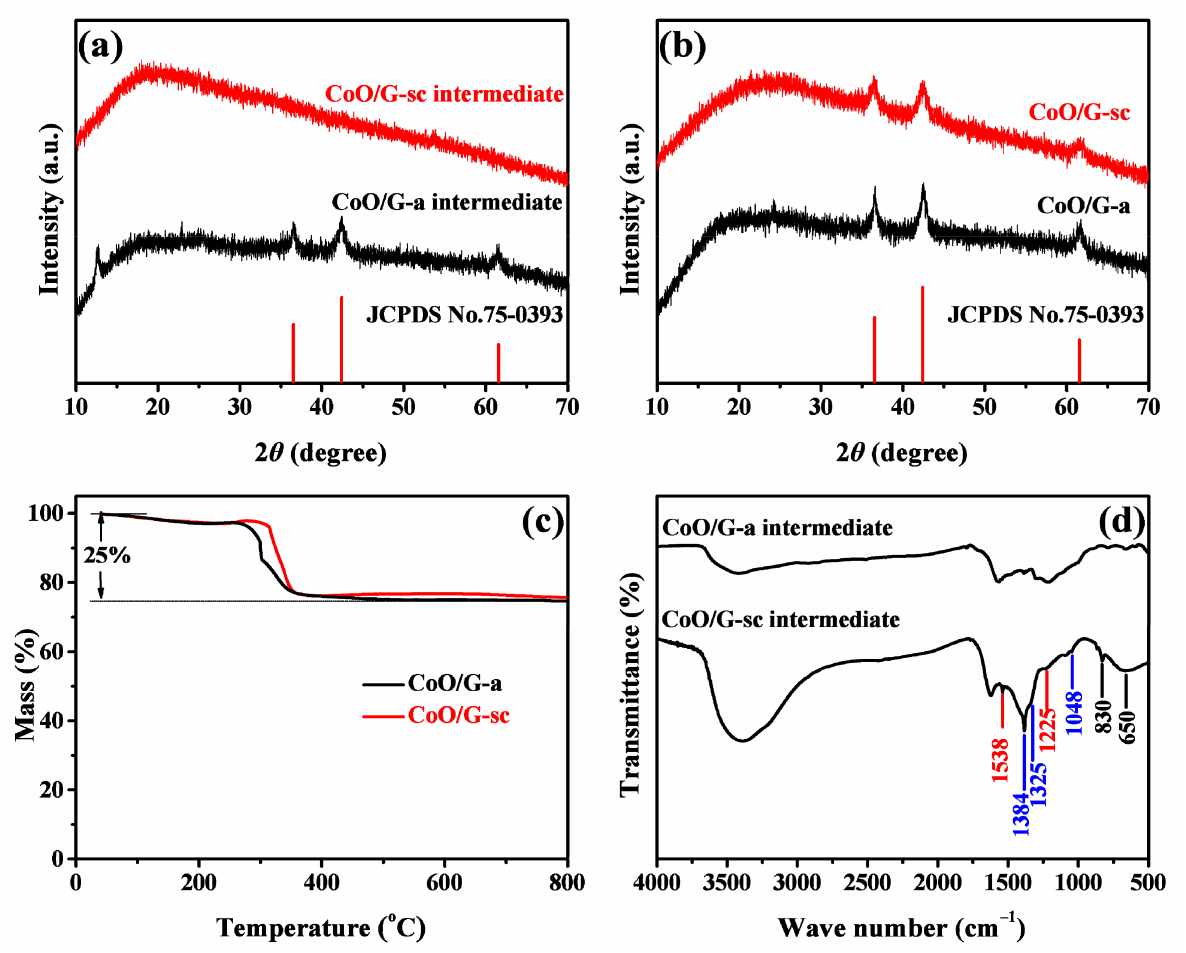
Figure 1. X-ray diffraction (XRD) patterns of ( a ) intermediates and ( b ) CoO/G-sc and CoO/G-a; ( c ) Thermogravimetric analysis (TGA) results of CoO/G-a and CoO/G-sc ( d ) FT-IR spectra of CoO/G-sc and CoO/G-a